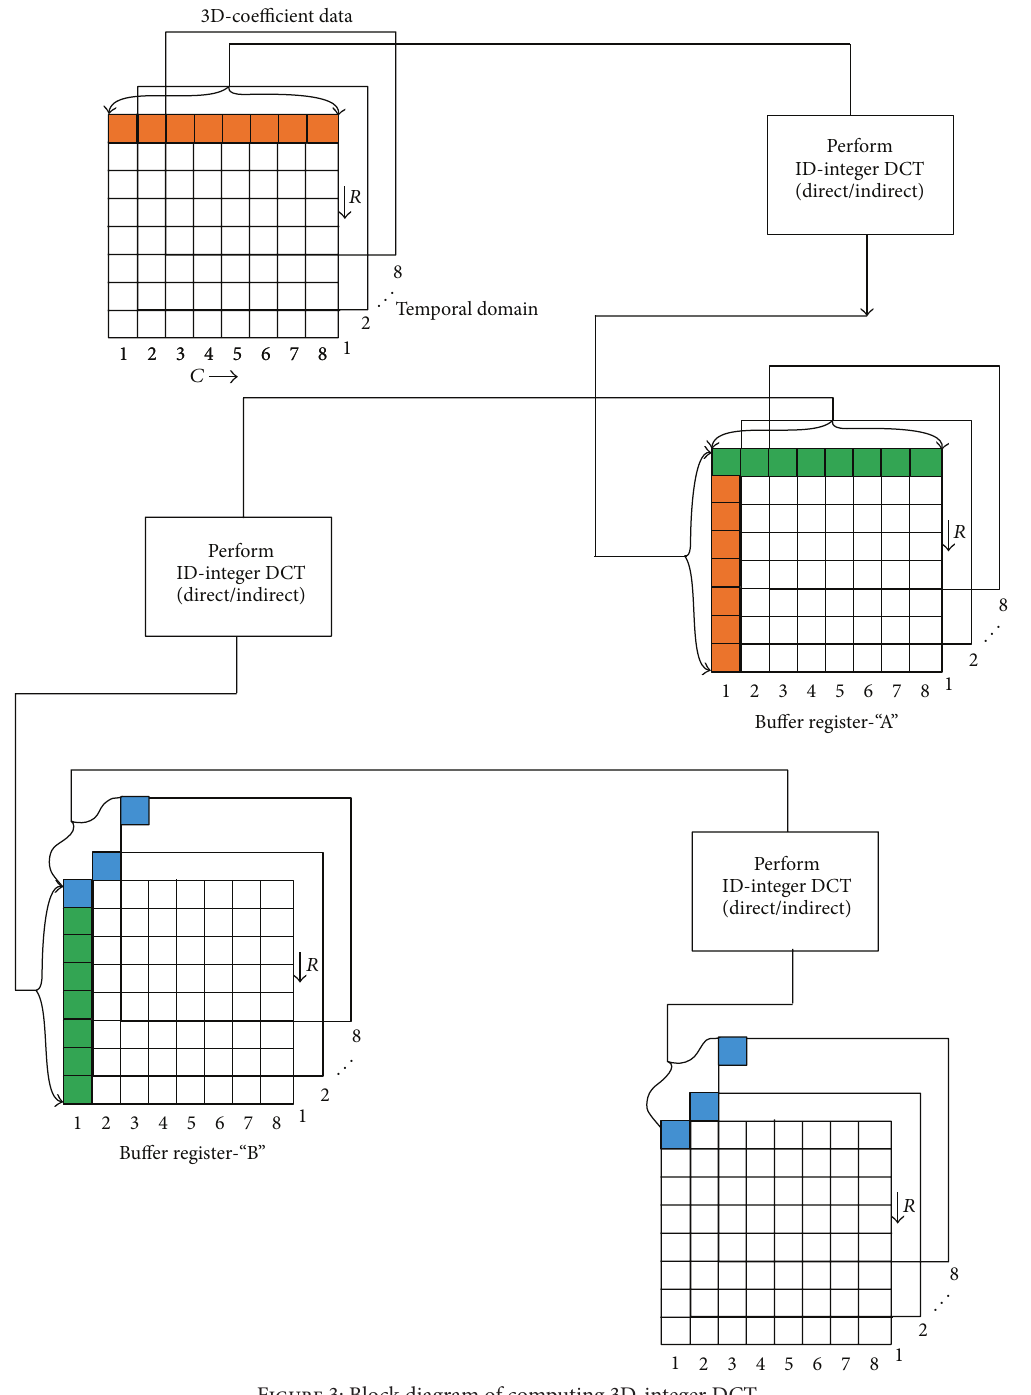
Figure 3: Block diagram of computing 3D-integer